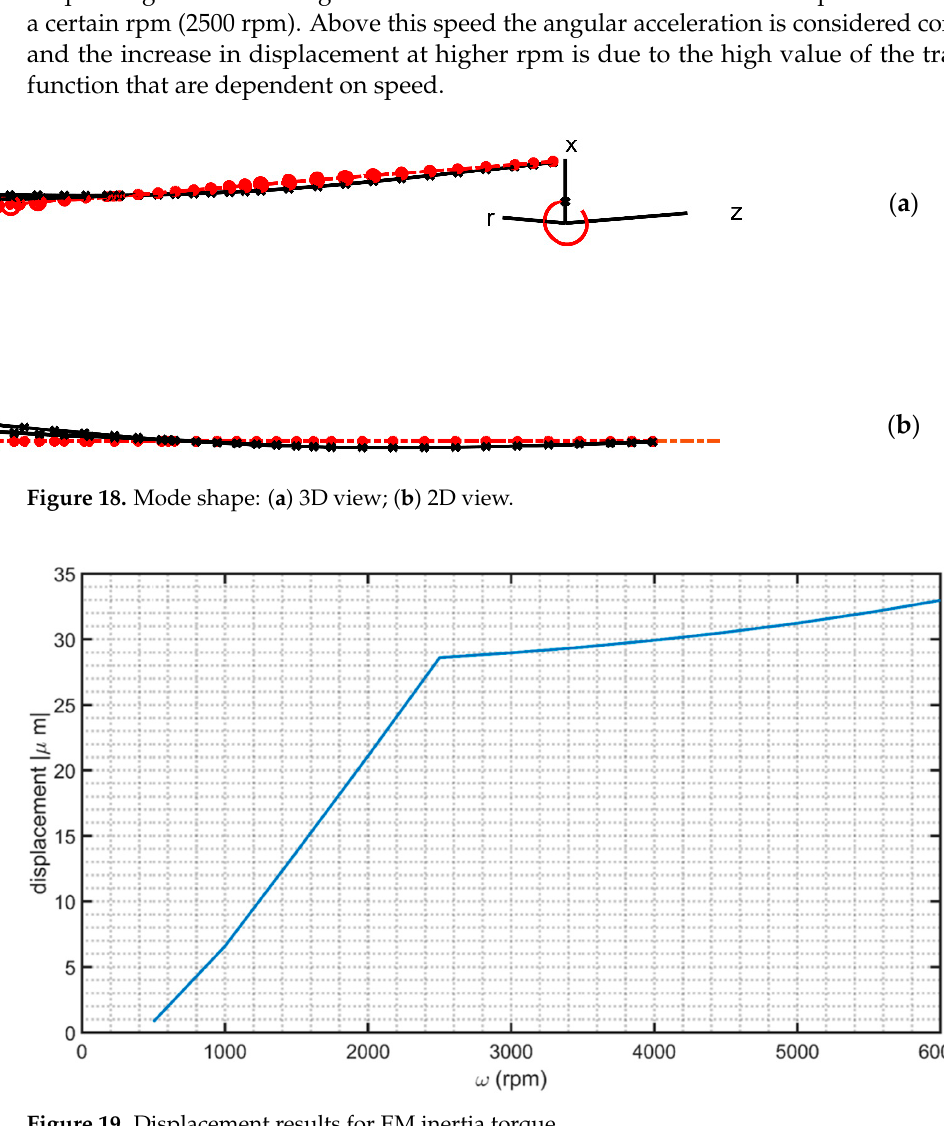
Figure 19. Displacement results for EM inertia torque.